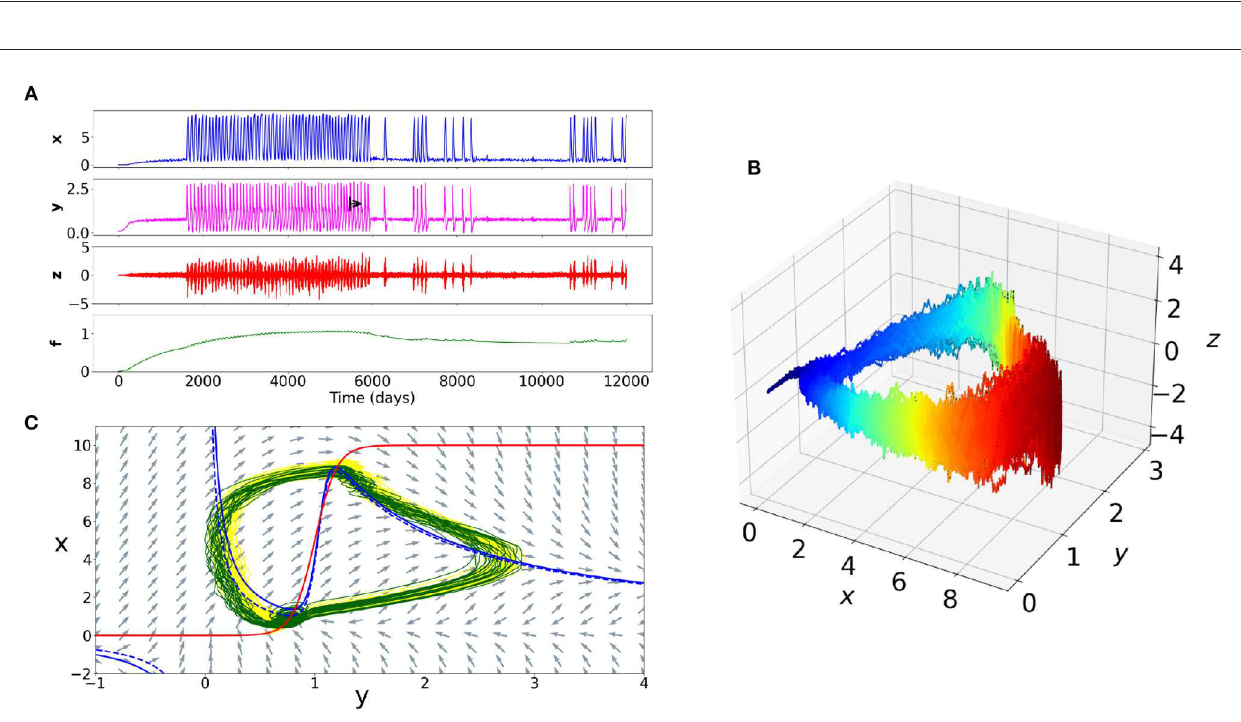
FIGURE4 Example of the dynamics of a simulation of a rapid cycling bipolar disorder. (A) Time series of the four variables. The black arrow corresponds to a therapeutic action on the internal elements of the patient (e.g., on neurotransmitters). The intensity of the symptoms becomes thus less frequent. (B) Trajectory in the phase space of the variables x , y , z . The blue color corresponds to a decrease in symptoms and the red color to an increase in symptoms. The cyclic nature of the trajectory appears clearly. The path at the onset of the peak of symptoms intensity is different than at the offset. (C) Plane of a subspace of the system. The NullClines of the equations x and y appear respectively in red and blue colors. The blue dotted line corresponds to the y NullCline after the change in the value of one of the parameters of the internal elements y . The difference between the dotted blue line and the solid blue line accounts the important change of dynamics between the yellow trajectory (before treatment) and the green trajectory (after